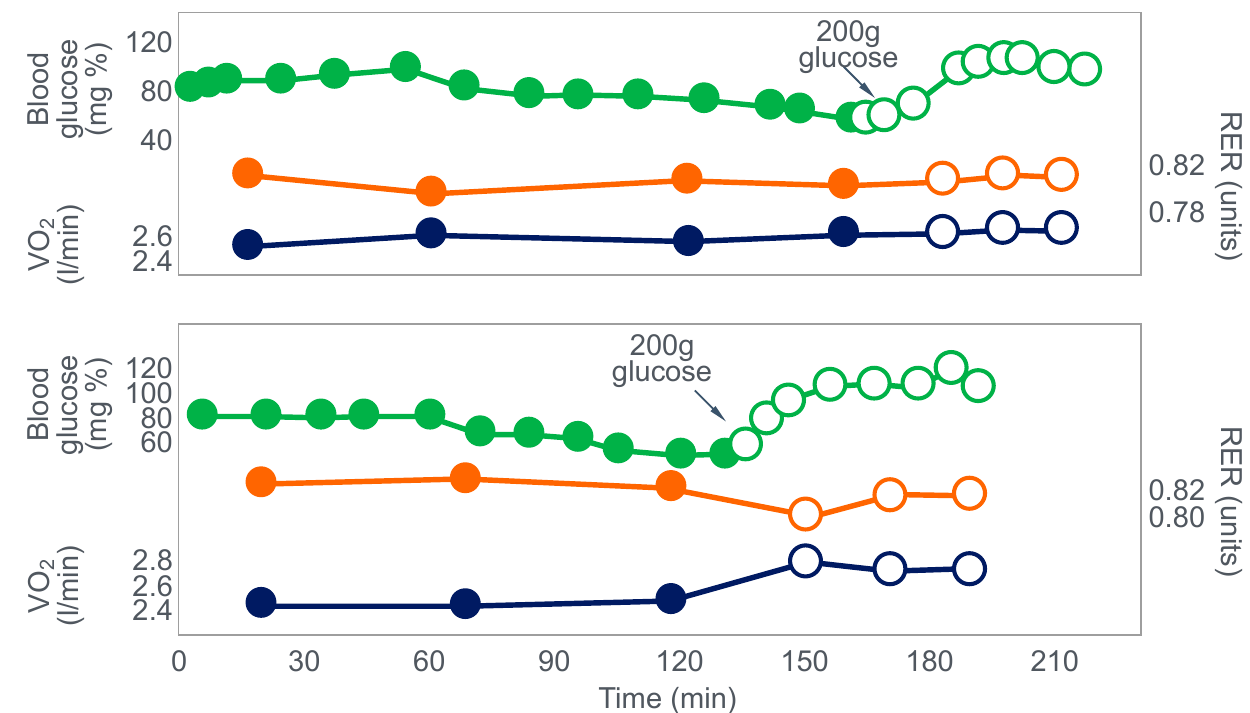
Figure 2. Changes in respiratory exchange ratio (RER) and blood glucose concentrations during prolonged exercise following high- and low-carbohydrate diets. Adapted with permission from ref. [14]. Copy-right 1939 Acta Physiologica (John Wiley and Sons).